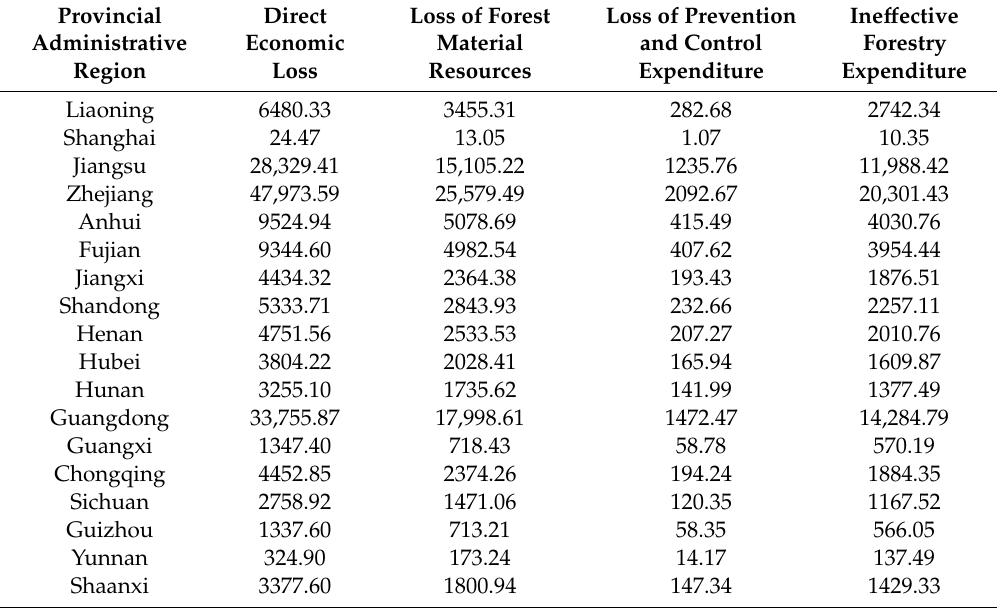
Table A9. Direct economic losses on the provincial level in Mainland China from 1998 to 2017 (Secondary indicators) / 10 4